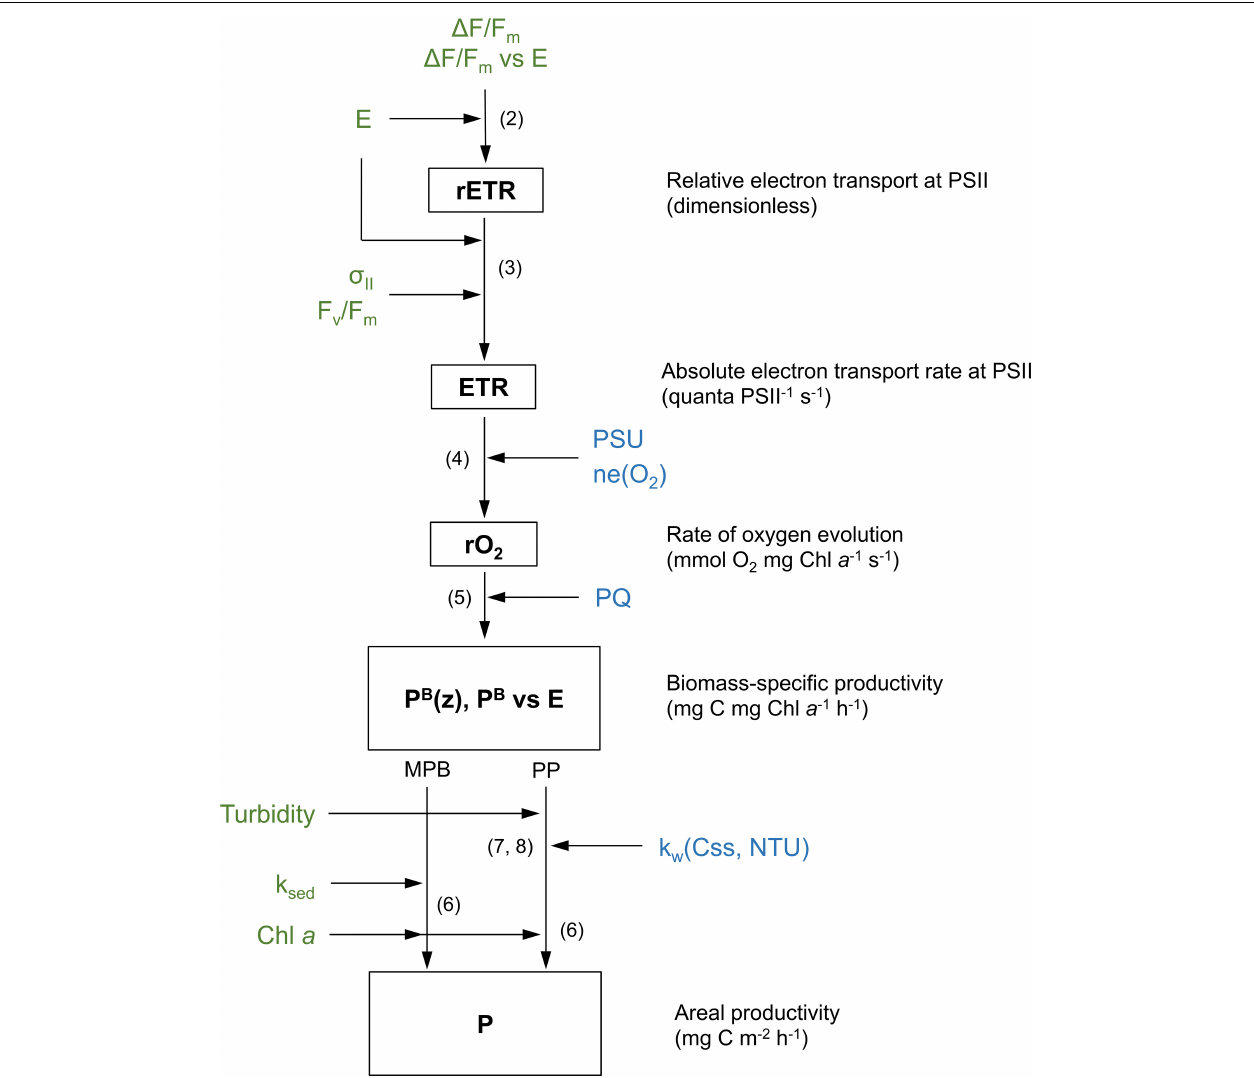
FIGURE 2 | Schematic describing the modeling workflow followed in this study. Biomass-specific productivity rates (P B , mg C mg Chl a − 1 h − 1 ) were calculated from irradiance (E) and fluorescence-based parameters (F v /F m , (cid:49) F/F m ’, σ II ). Productivity per unit area was calculated by depth-integrating P B using light-response curves of P B , chlorophyll a content, and light attenuation. Depth-integration was carried out differently for phytoplankton (PP) and microphytobenthos (MPB), using light attenuation coefficient for the water column (k w ) and the sediment (k s ), respectively. Parameters in green were measured in this study. Parameters in blue were taken from published sources. Numbers represent the equations describing each